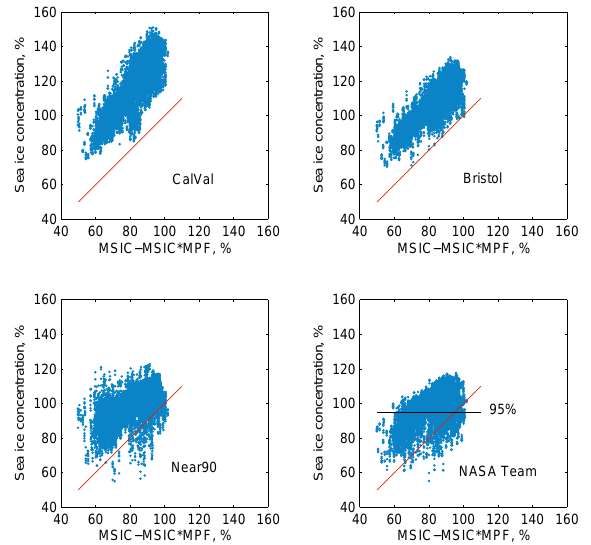
Figure 3. Sea ice concentration (SIC) in % ( y axis) obtained from AMSR-E brightness temperatures by four algorithms (names shown in the panels) for the Arctic Ocean as a function of the net ice surface fraction obtained by MODIS for 21 June–31 August 2009 (where MSIC stands for MODIS SIC and MPF – melt pond frac- tion). The red lines show the one-to-one regressions. The black line shows the 95% SIC for the NASA Team algorithm (the limit used for the dynamic ice tie point).